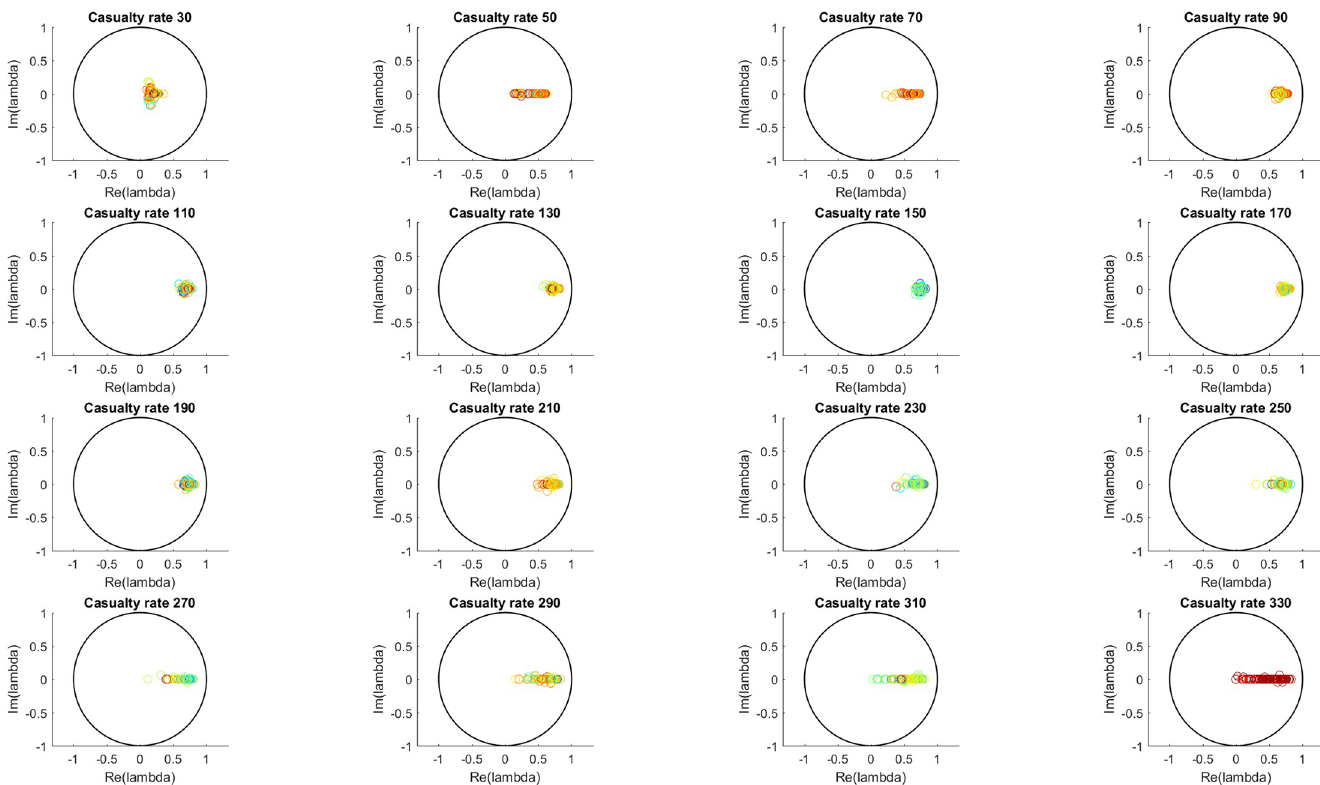
Fig 9. Eigenvalue distribution of second mode for each casualty source rate. The color scale (blue to red) indicates the L-2 norm of each eigenvalue’s associated Koopman mode. The second mode eigenvalues are seen to represent the general dependence on casualty source rate of the all eigenvalue case shown in Fig 5.